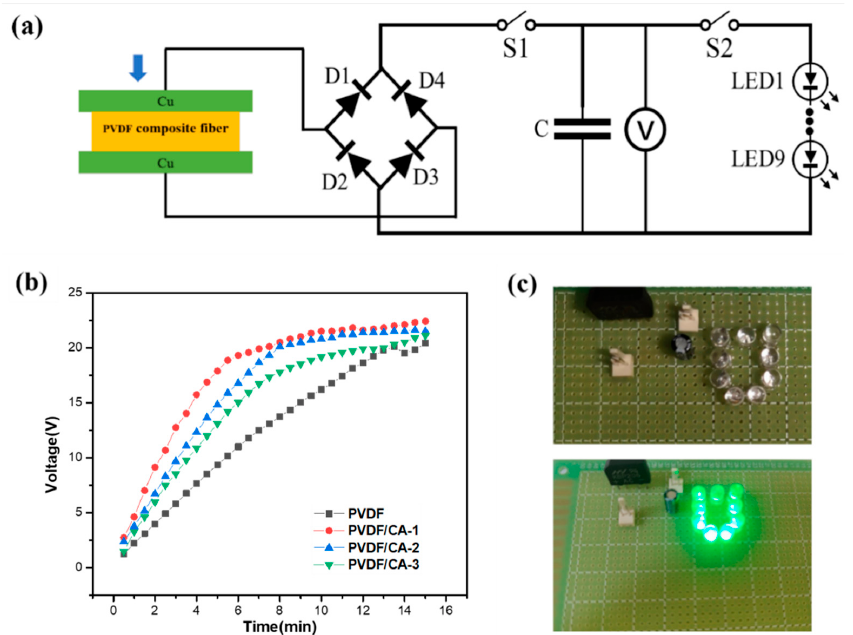
Figure 9. Piezoelectric response of PVDF/CA EFMs: ( a ) the circuit diagram of the commercial capacitor charged with PVDF/CA EFMs-based PENGs; ( b ) voltage–time curves of capacitor charging; ( c ) LED lighting driven by capacitive discharge with PVDF/CA EFM-based PENGs.